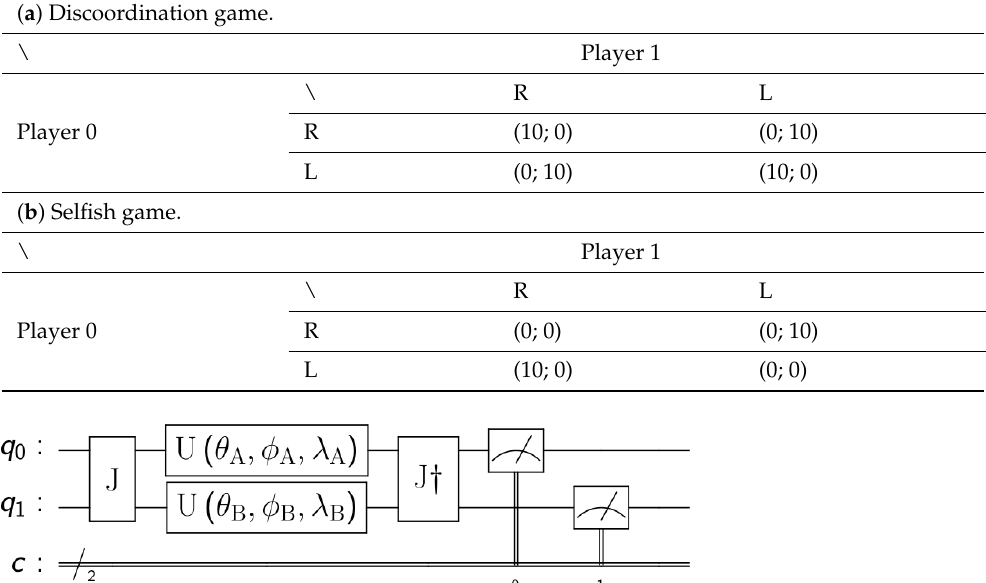
Figure 1. EWL game model for 2 players. Where q 0 and q 1 are the initial quantum states of the players and c is a classical register where the qubits measurements are